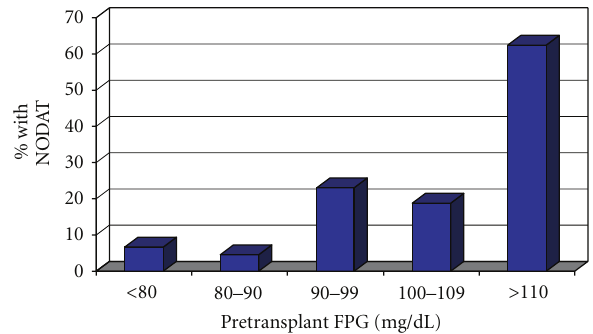
Figure 1: Incidence of NODAT by pretransplant fasting plasma glucose ( N =